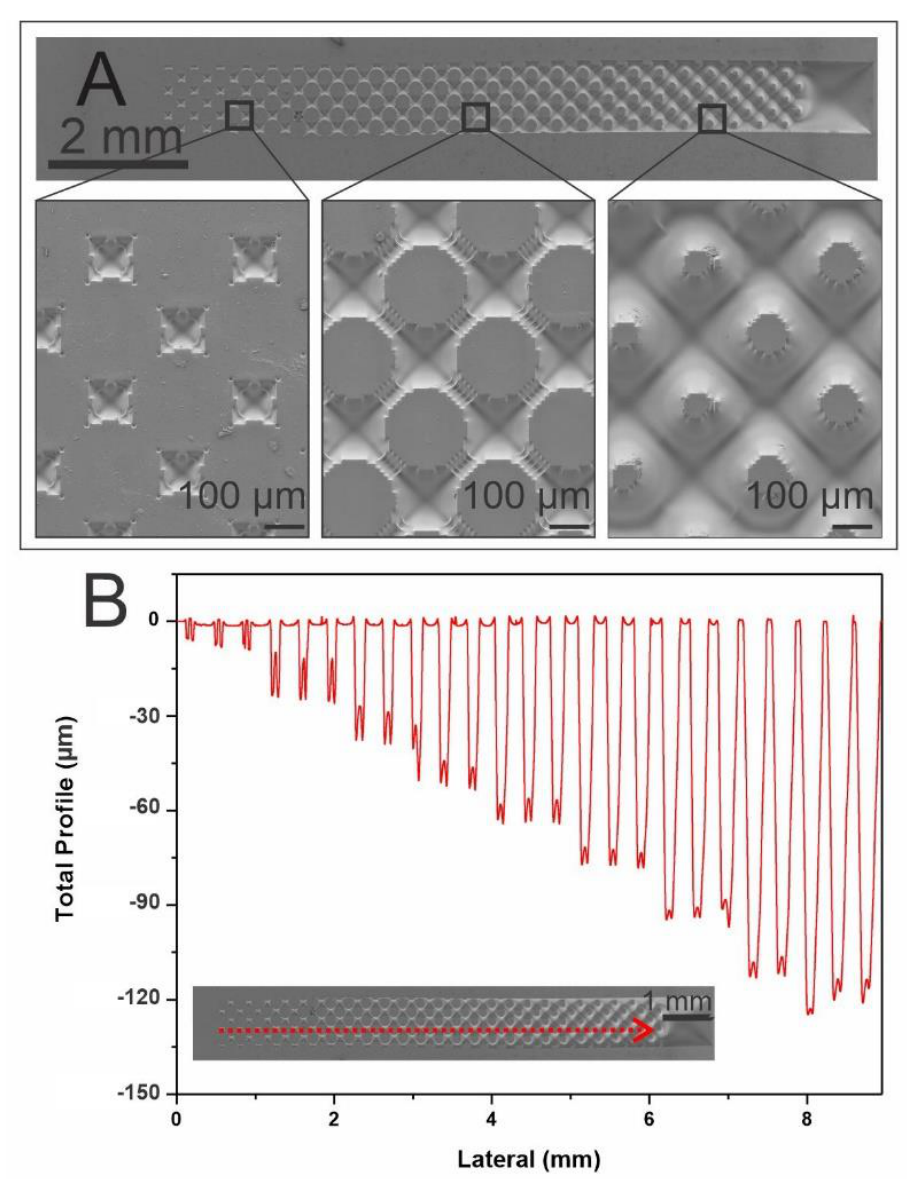
Figure 3. ( A ) SEM images of the 3D patterns of the PDMS stamp obtained from ERmold showing a magnification in three different areas. ( B ) profilometry profiles of the 3D structures of the PDMS replica obtained. Insert: SEM image shows the path on the structure profiled .